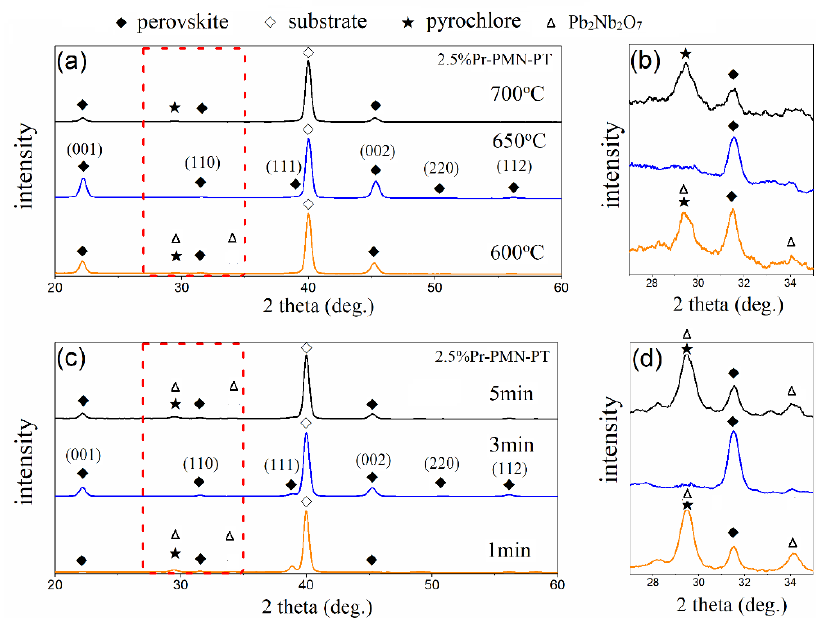
Figure 1. XRD patterns of 2.5% Pr 3+ doped Pb(Mg 1/3 Nb 2/3 )O 3 -0.30PbTiO 3 (Pr-PMN-PT) thin films as a function of annealing temperatures between 600 ◦ C and 700 ◦ C: ( a , b ); XRD patterns of 2.5% Pr-PMN-PT thin films annealed at 650 ◦ C as a function of annealing times between 1 min and 5 min: ( c , d ).